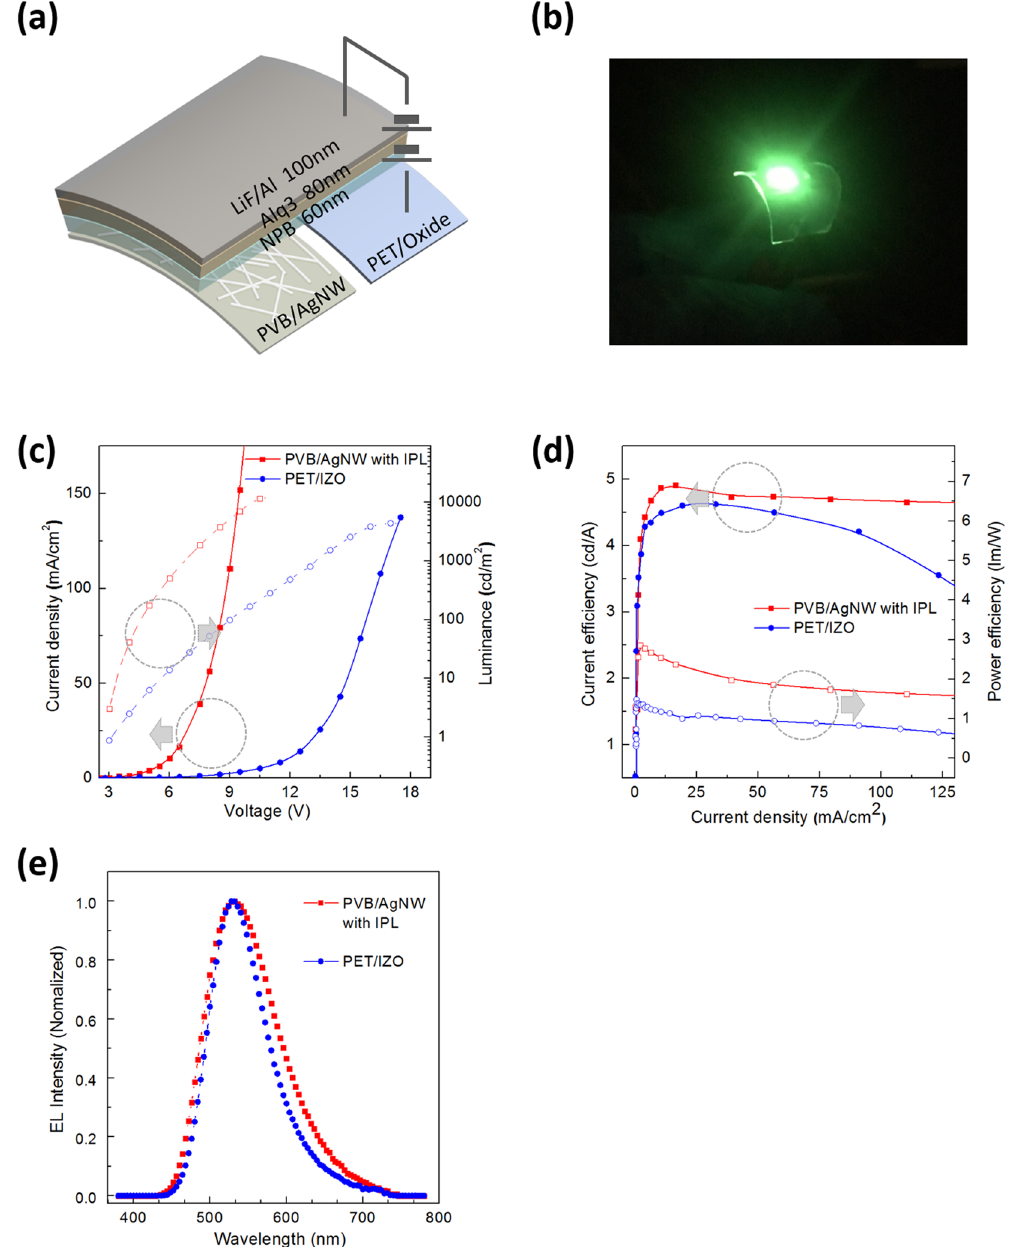
Figure 5. Characteristics of OLED devices with PVB/AgNWs with IPL composite and IZO anode. ( a ) Schematic section of the OLED device. ( b ) Photographic images of operating PVB/AgNWs-based OLEDs in flexible modes, compressive stress. ( c ) Current density–voltage-luminance characteristics. ( d ) Current efficiency and power efficiency as a function of luminance. ( e ) Normalized EL intensity versus wavelength.